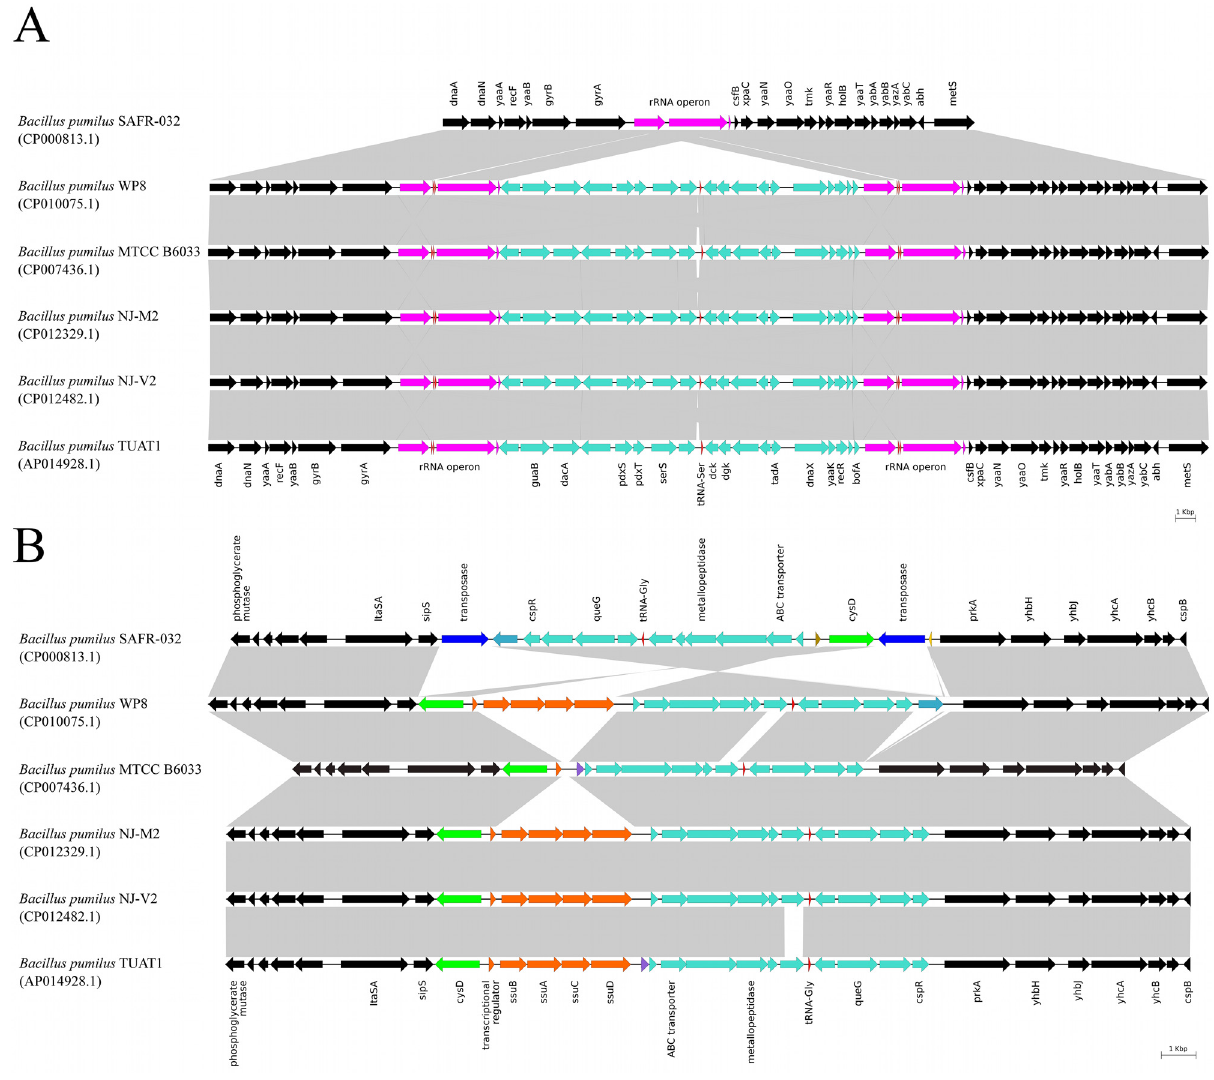
Fig 1. Synteny violations between the complete genomes of B . pumilus SAFR-032 (CP000813.1) and other B . pumilus strains. Only de novo assembled genomes of B . pumilus strains were considered. Multiple genome alignments were performed with the Progressive Mauve Aligner [34]. The aligned segments of interest were further evaluated with BLASTN and visualized using Easyfig [35]. Genes within homologous syntenic blocks are colored with the same color except transposase, rRNA and tRNA genes, which are colored in blue, magenta and red, respectively, regardless of their belonging. Perfectly syntenic gene clusters present in all aligned genomes in the same orientation are shown in black. (A) dnaA (BPUM_0001) — metS (BPUM_0022) genome fragment. (B) gpmB (BPUM_0834) — cspB (BPUM_0862) genome